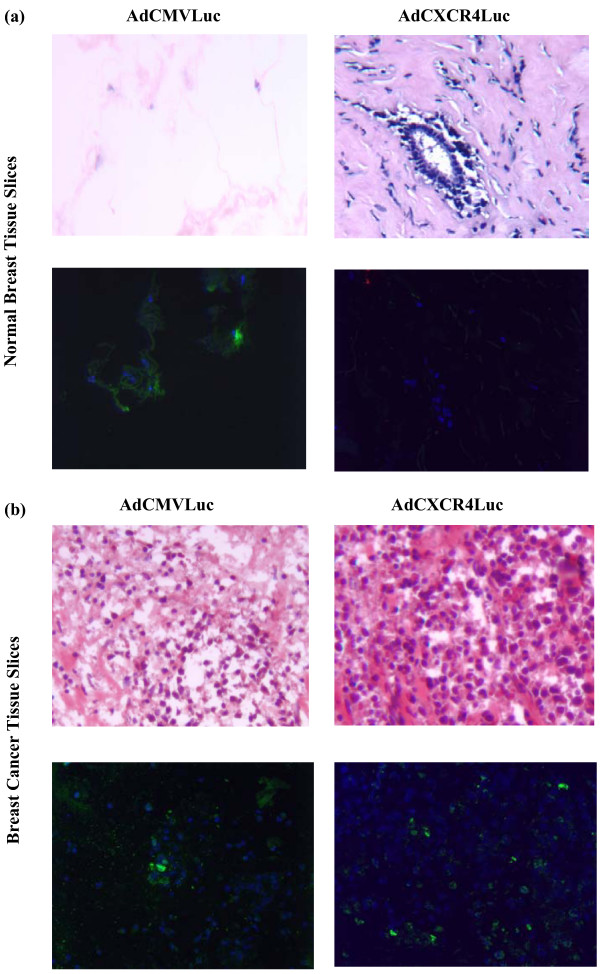
Visualization of luciferase expression pattern of AdCXCR4Luc and AdCMVLuc in normal breast tissue slices versus breast cancer tissue slices. The upper panels show the tissue morphology as revealed by hematoxylin-and-eosin staining of thin sections of (a) normal breast tissue slices and (b) breast tissue slices. Representative indirect immunfluorescent detection of luciferase expression is shown in the lower panels for (a) human normal breast tissue slices and (b) breast cancer tissue slices infected with AdCXCR4Luc and AdCMVLuc. AdCMVLuc infected (a) normal breast tissue slices (lower left panel) and (b) breast cancer tissue slices (lower left panel) show immunofluorescent detection of the luciferase protein (green fluorescence), whereas (a) AdCXCR4 infected normal breast tissue slices (lower right panel) do not display luciferase activity. In contrast, (b) AdCXCR4 infected breast cancer tissue slices reveal luciferase activity (lower right panel). DAPI (4'6-diamidino-2-phenylindole 2HCL) staining (blue) indicates nuclei. Magnification ×200.